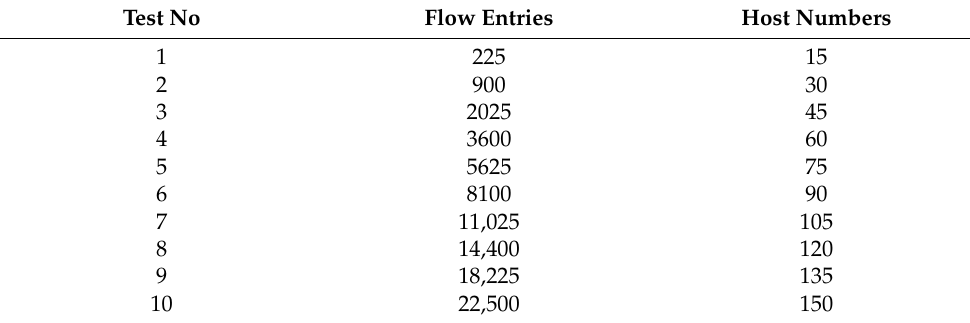
Table 3. Flow Entries using different Host